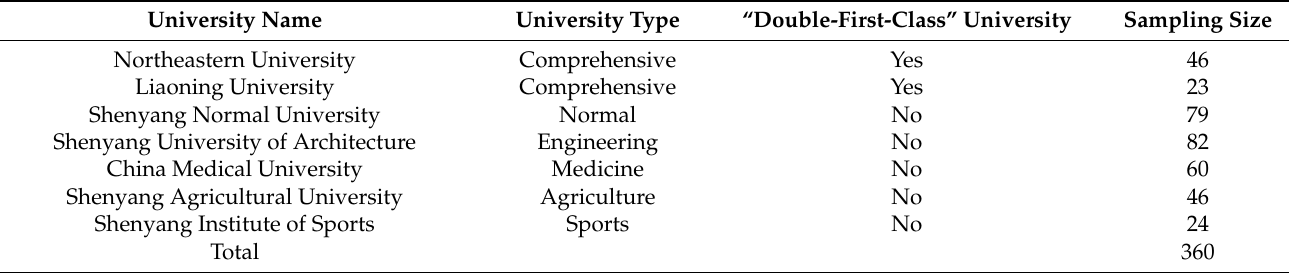
Table 1. Sample distribution of